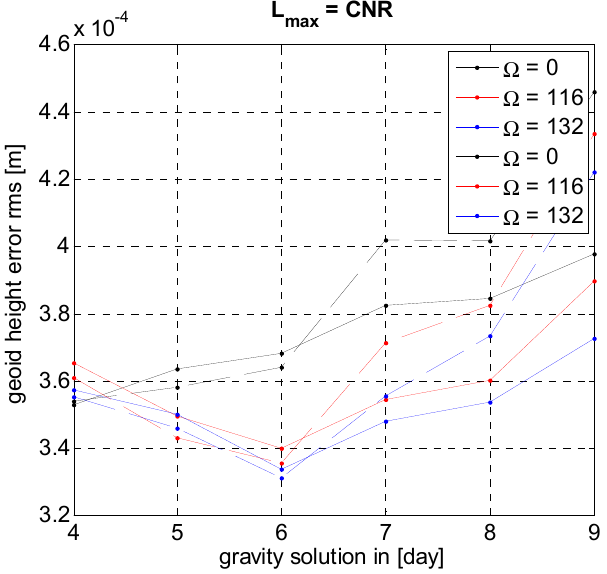
Figure 10. Global error RMS in terms of geoid height for odd (solid line) and even (dashed line) parities (inline scenarios a and b of the Table 2, respectively) for the gravity solutions up to maximum spherical harmonic degree and order CNR. Different colors stand for different Ω .